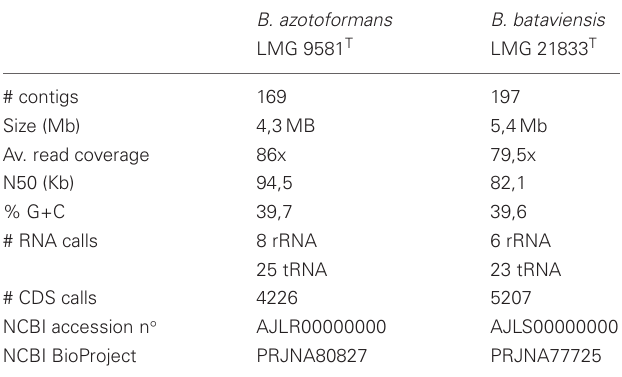
Table 1 | Genome characteristics of both analyzed